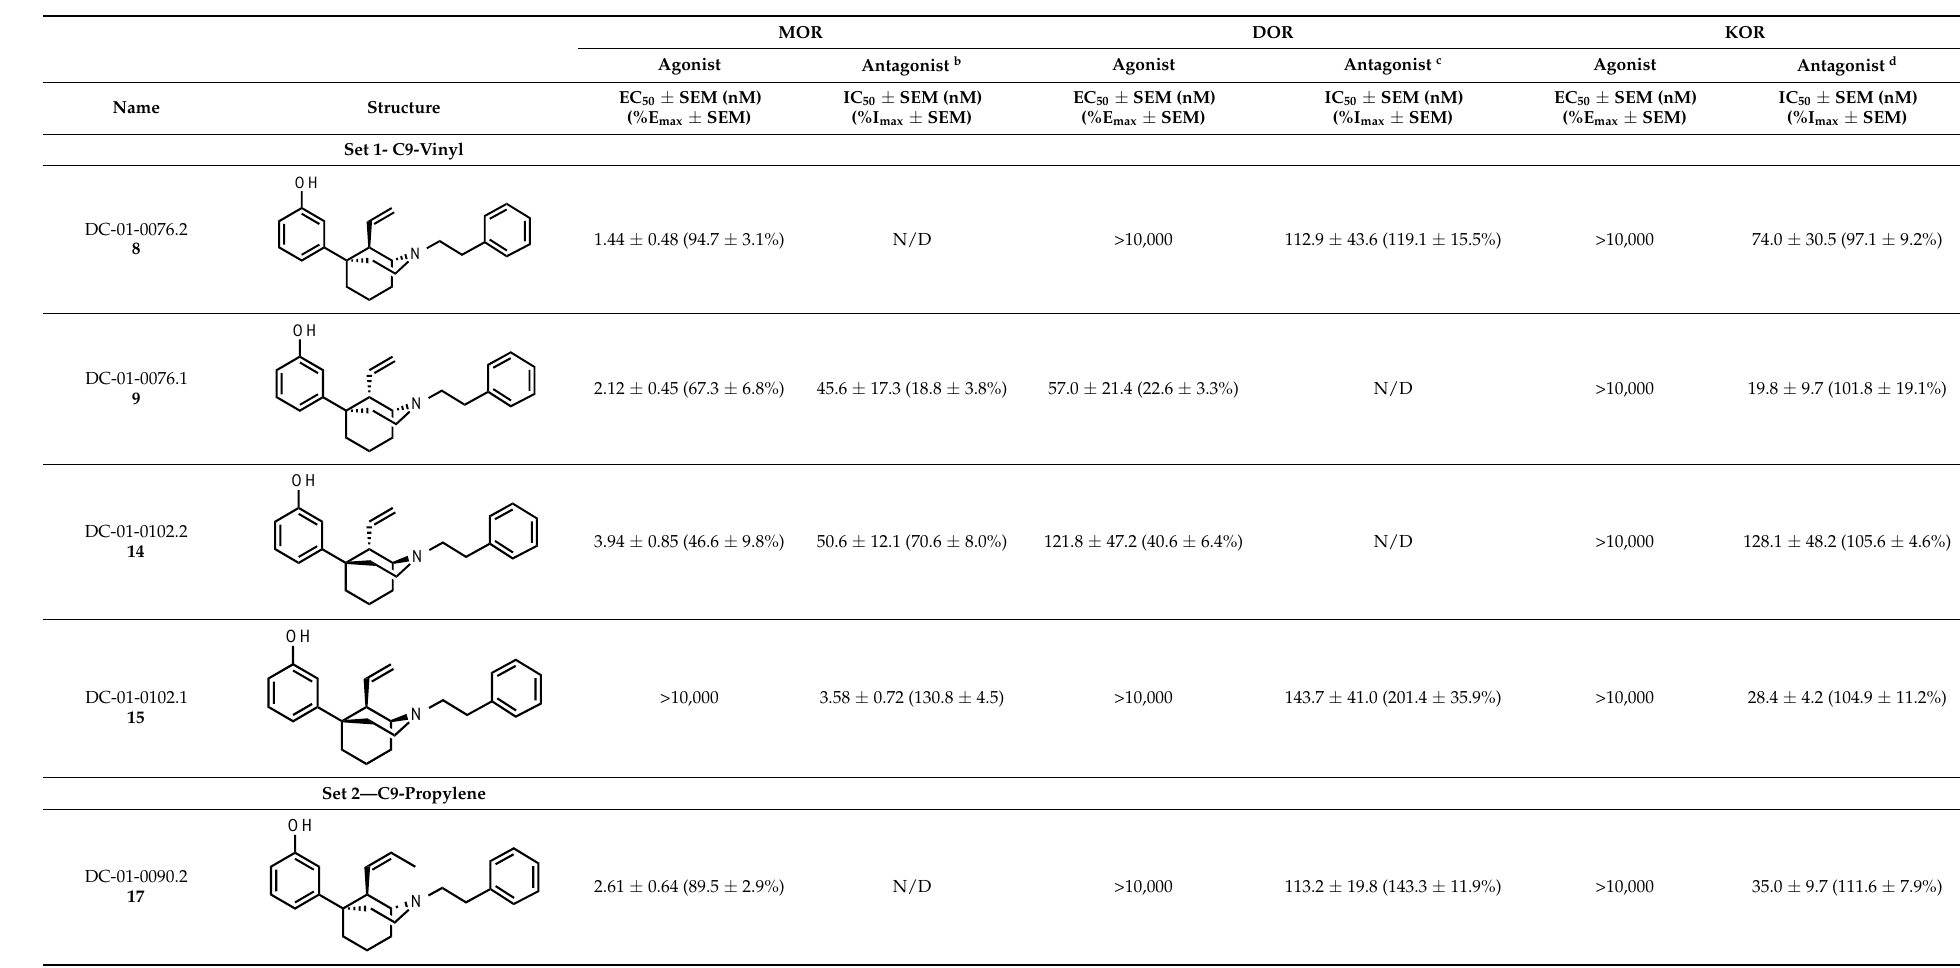
Table 2. Opioid Receptor Activity Measured in the Forskolin-induced cAMP Accumulation Assay a . MOR DOR KOR Agonist Antagonist b Agonist Antagonist c Agonist Antagonist d